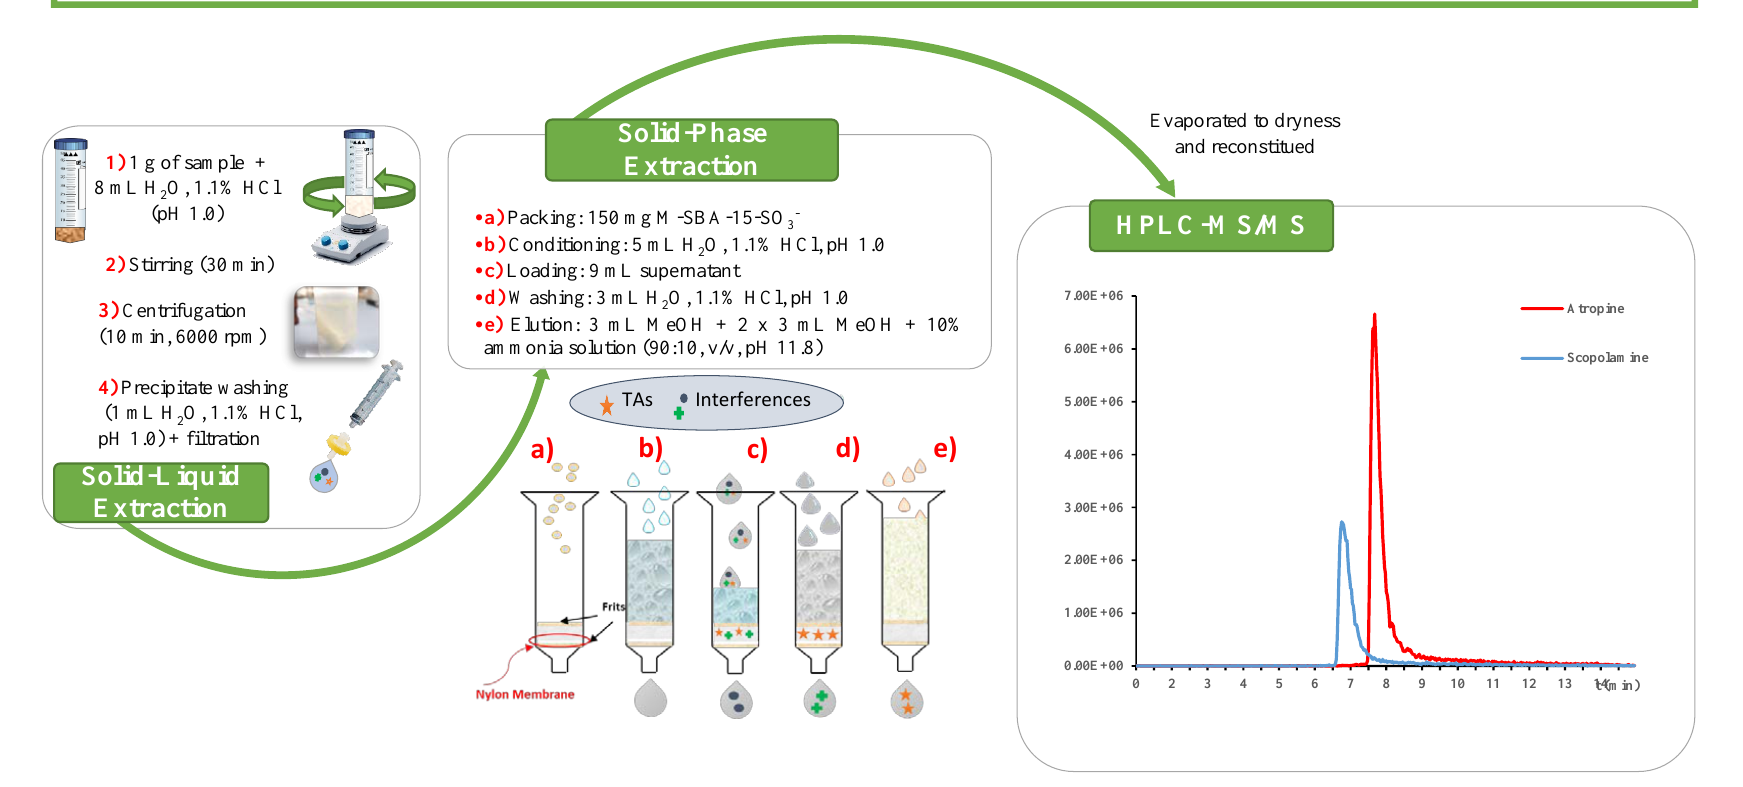
Figure 1. Schematic representation of the optimized extraction procedure and chromatographic